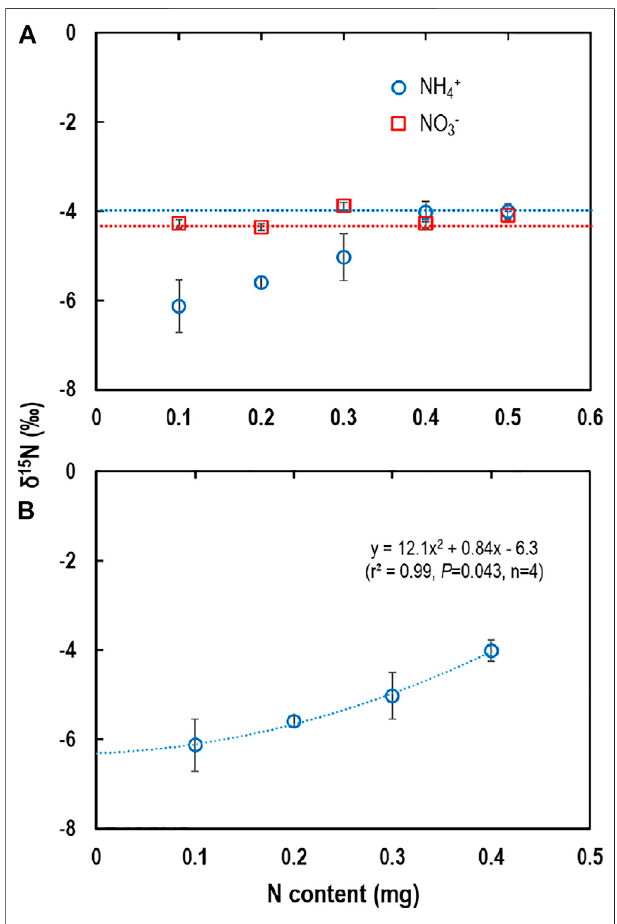
FIGURE 3 | δ 15 N-NH 4+ and δ 15 N-NO 3 − measured with distillation: (A) − with increased N content from 0.1 to 0.5 mg N δ 15 N-NH 4+ and δ 15 N- NO 3 and (B) regression between N content and δ 15 N of NH 4+ for 0.1 – 0.4 mg N sample (0.5 mg N was not included as accuracy was high enough). Verticalbarsarethestandarddeviationofthemeans( n =4).For (A) ,horizontal broken-lines are the reference δ 15 N values of NH 4+ (blue one) and NO 3 − (red one) determined directly with EA-IRMS. For (B) , the y -intercept of the regression equation indicates that the δ 15 N of background contamination is ‒ 6.3 ‰